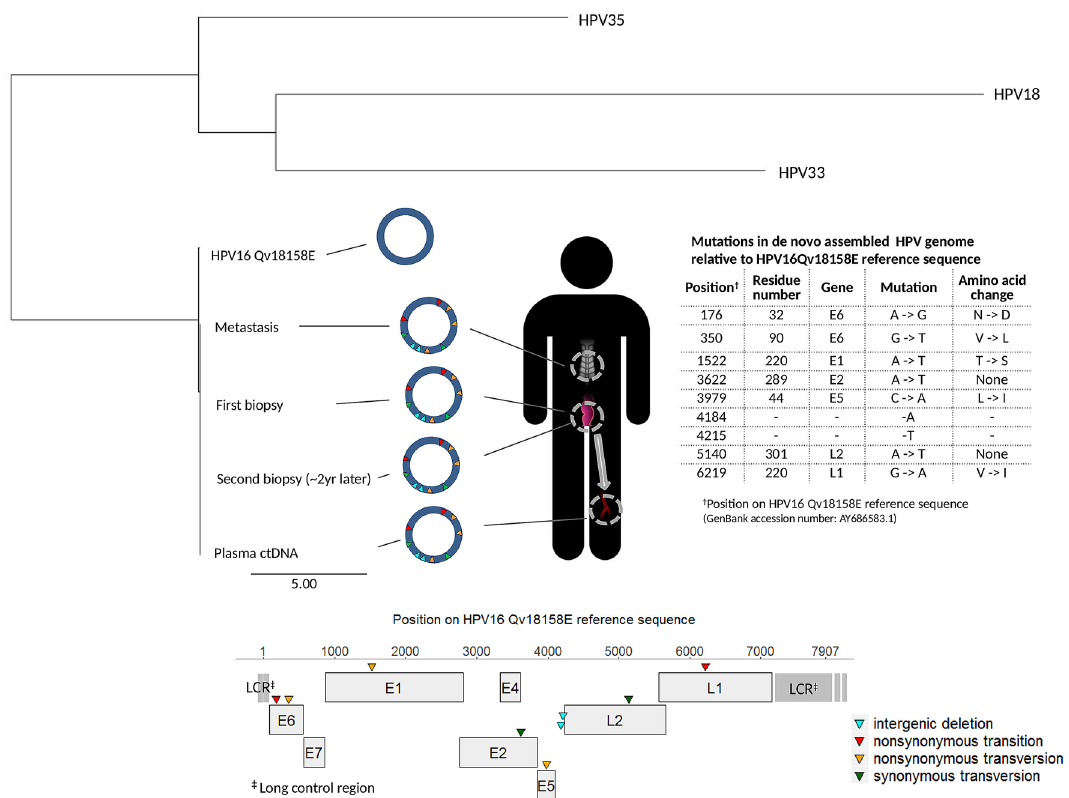
Figure 1. Phylogenetic tree using the neighbor joining method including the 4 patient HPV full length nucleotide sequences from the initial (June 2016) and second (July 2018) anal biopsy samples, from plasma sample (May 2018) and from vertebral metastasis biopsy (July 2018) and the HPV16 Qv18158E, HPV18, HPV33 and HPV35 reference sequences. The human junction positions are expressed relative to reference human sequence GRCh37/hg19. The scale refers to the distance between sequences. The 4 patient HPV16 full length sequences were episomal without any integration in the human genome. All 4 patient HPV sequences showed 7 nucleotide mutations by reference to HPV16 Qv18158E, including 2 nonsynonymous transitions, 3 nonsynonymous transversions and 2 synonymous transversions, and 2 nucleotide deletions, whose positions, genes and amino acid changes are depicted by reference to the HPV16